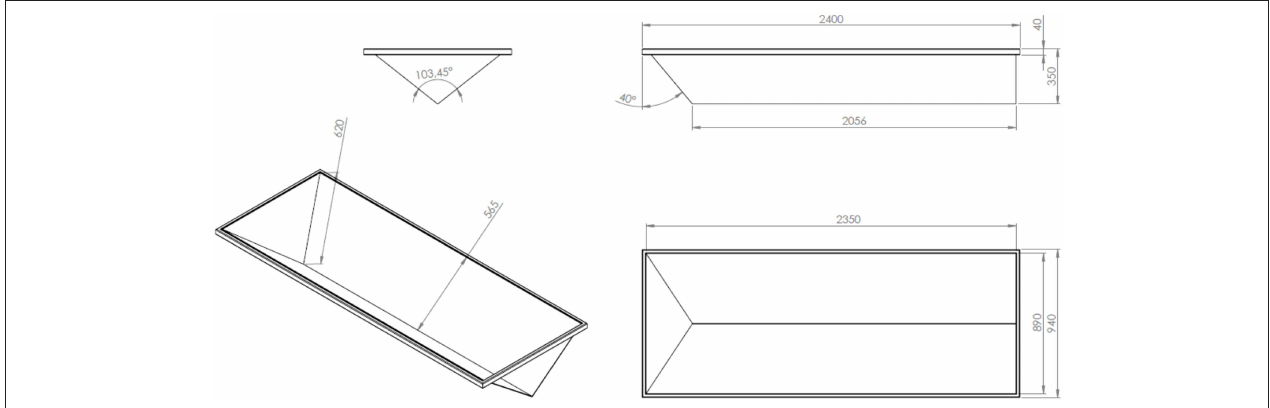
FIGURE 3 | Technical drawing of the canyon